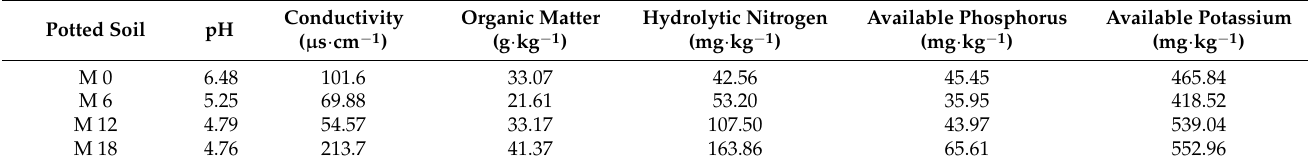
Table 1. Basic soil conditions of different potted bamboo seedlings.